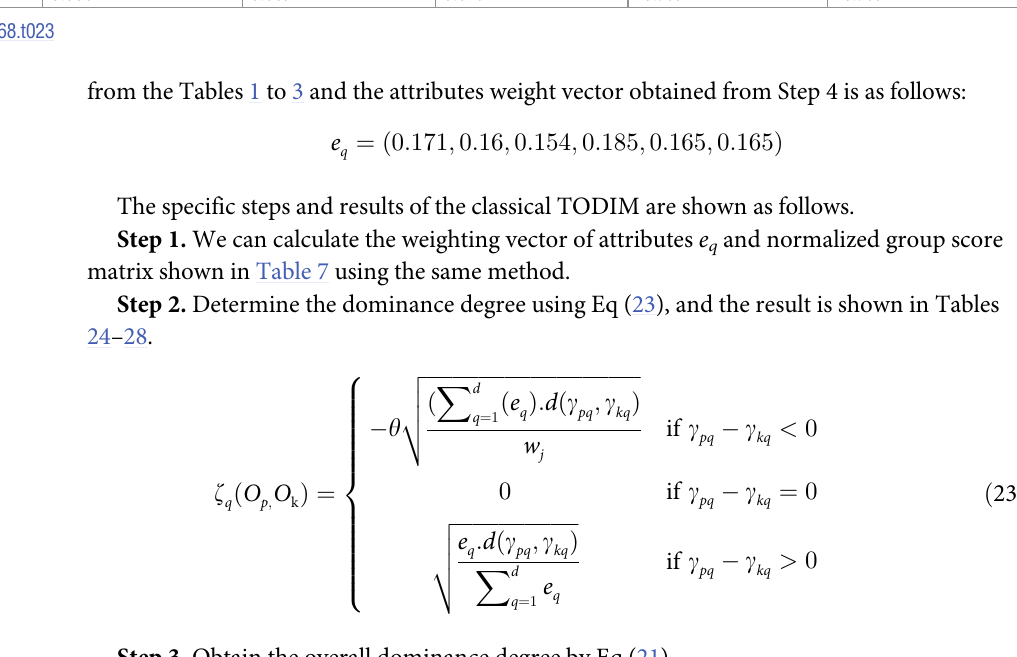
Step 3. Obtain the overall dominance degree by Eq (21). Table 24. The dominance of O 1 to others.